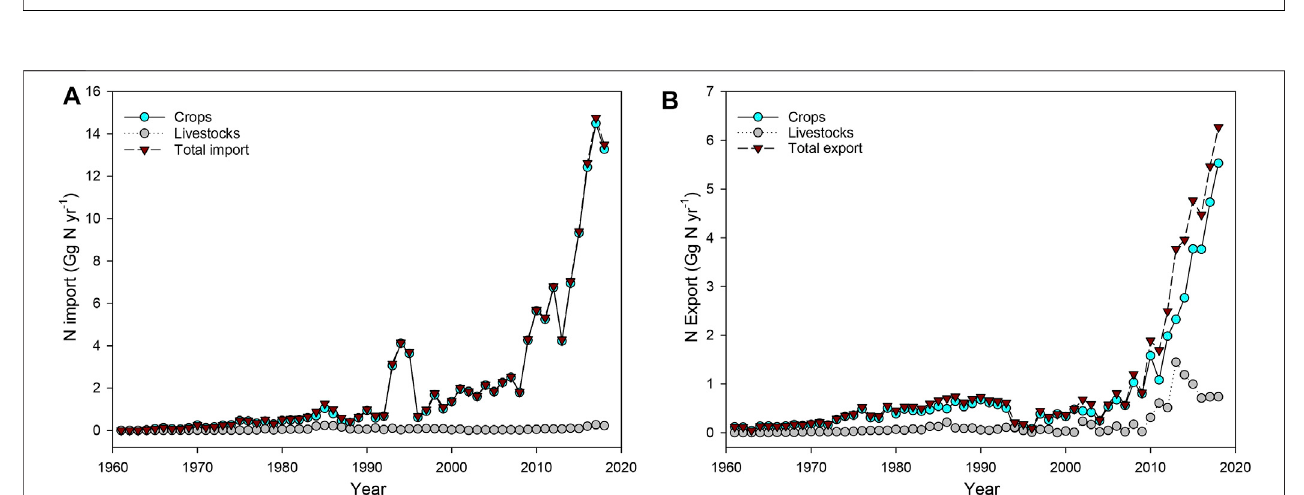
FIGURE 2 | Historical changes in total NH 3 -N, NO 2 -N, and NO emissions (A) , and total N gaseous emissions from animal N manure and synthetic N fertilizer (B) in Rwanda.